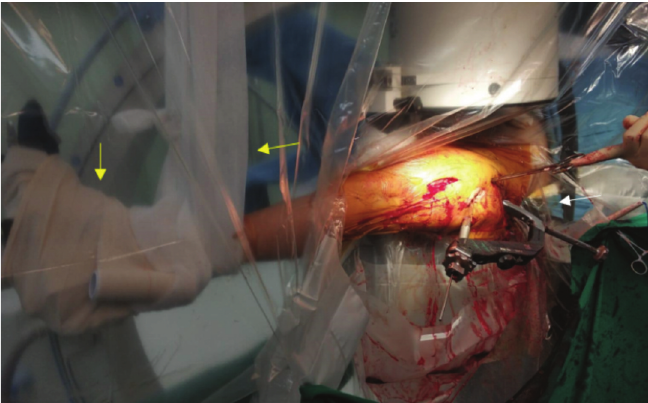
Elastoplast used to secure the foot and a sling was applied to prevent the foot from slipping off the foot traction (yellow Fig. 2: arrows). The incision for entry point was more proximal and posterior to get centre-centre blade position (white arrow).